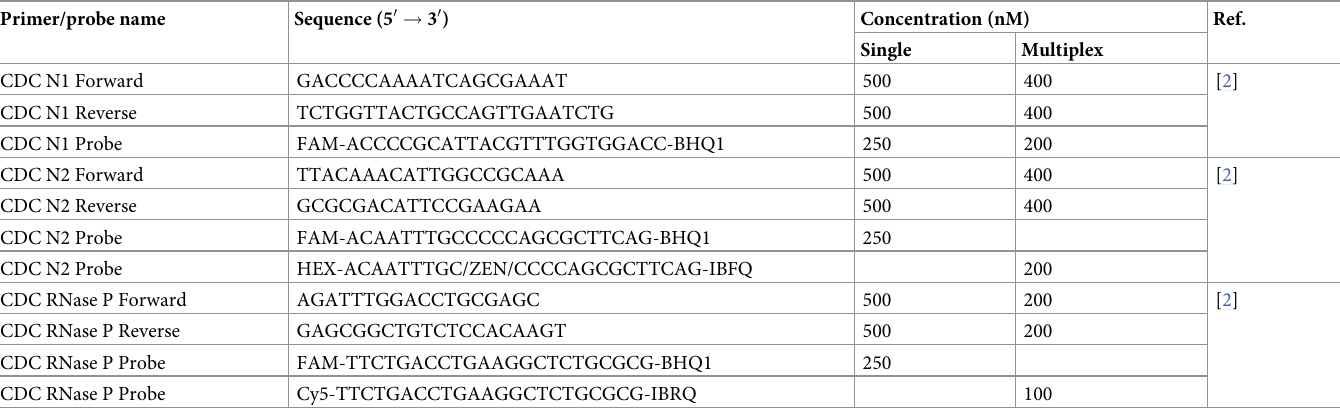
Table 4. Primers and probes for single and multiplex